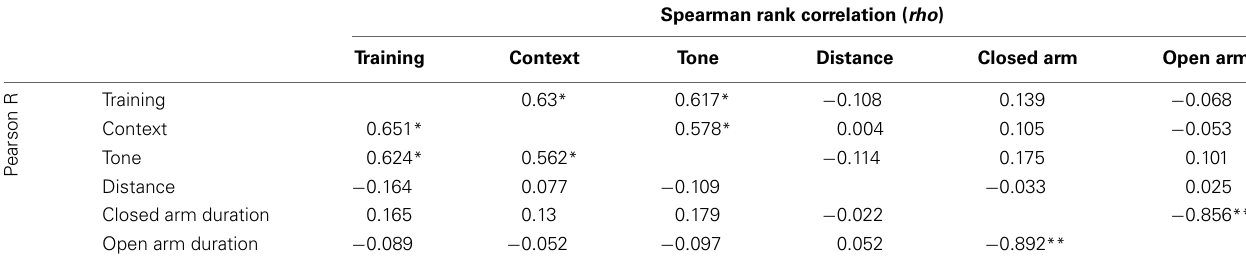
Table 2 | Correlation of traits measured in stress